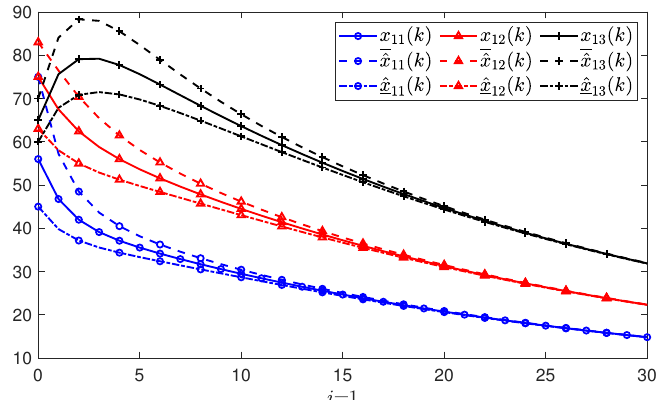
Figure 3. The simulations of all states and their estimations of the first agent.